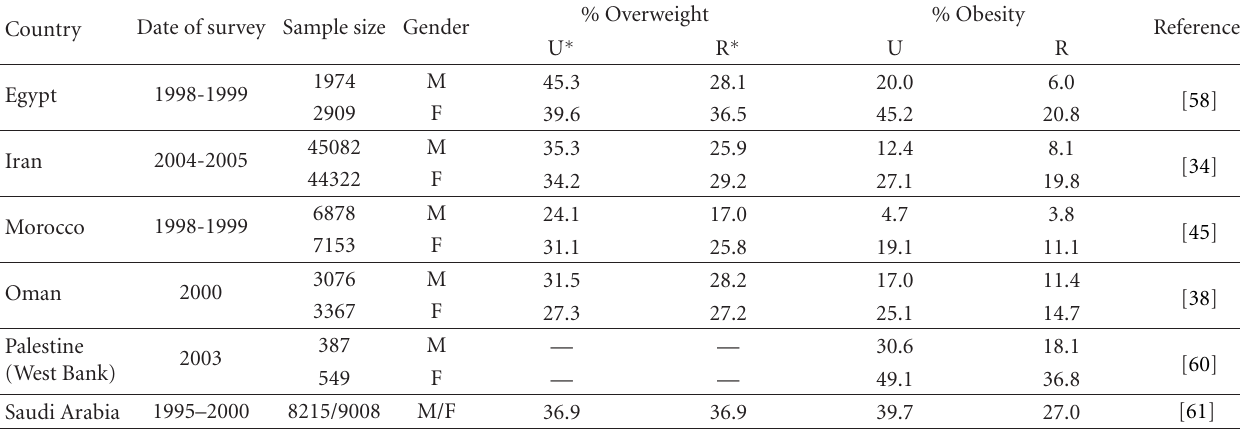
Table 6: Prevalence of overweight (BMI ≥ 25) and obesity (BMI ≥ 30) among adults in urban and rural areas in selected EMR countries. Country Date of survey Sample size